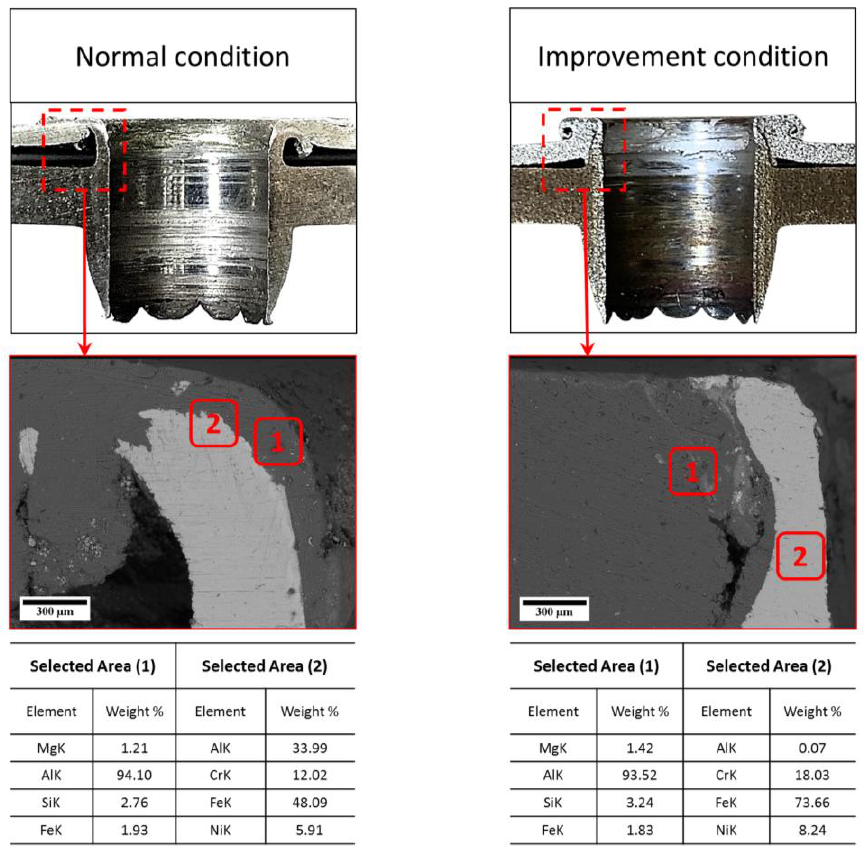
Figure 15. Cross-section and close-up views, and energy-dispersive X-ray analysis of back-extruded materials zones for friction-drilled joints, under normal and improvement conditions.